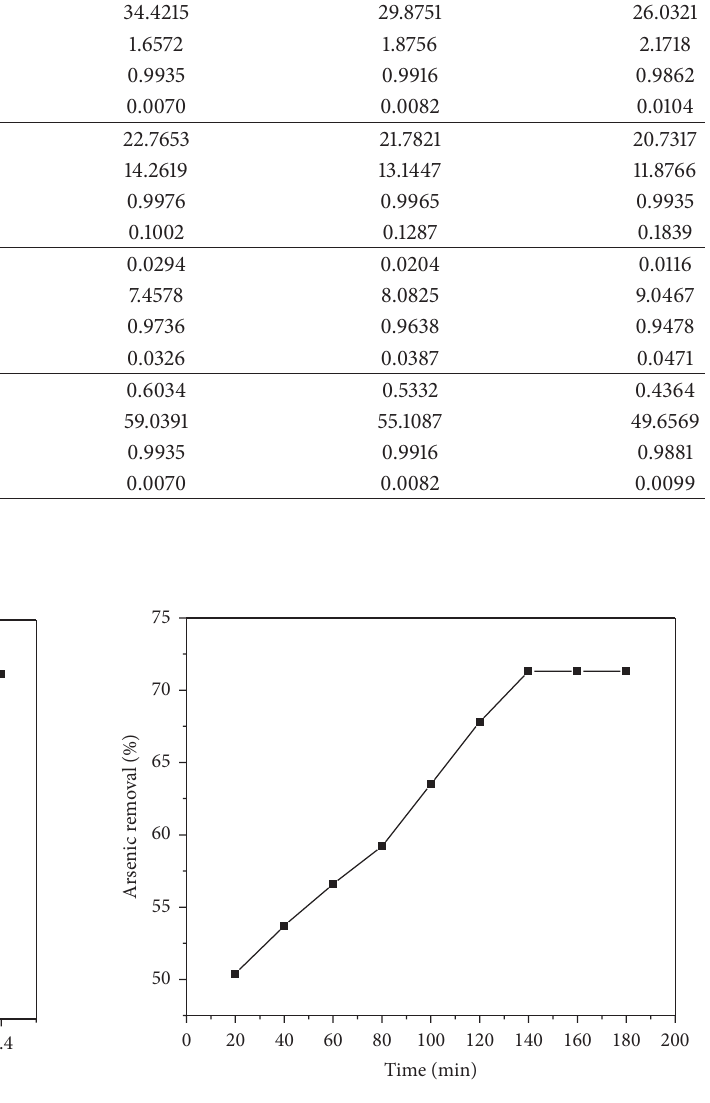
Figure 1: Effect of adsorbent dose on biosorption of arsenic. Figure 2: Effect of time variation on biosorption of